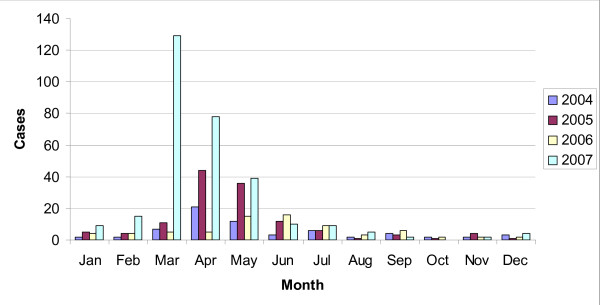
Distribution of cryptosporidiosis each month over four years.